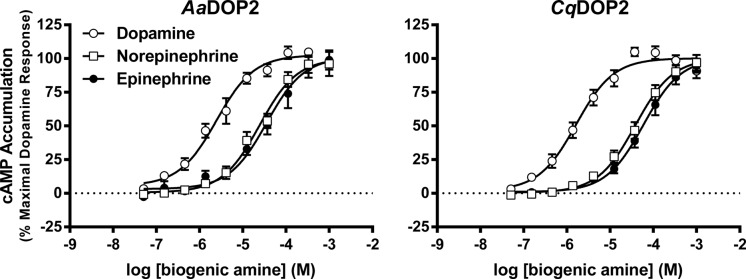
Pharmacological characterization of AaDOP2 and CqDOP2 stably expressed in HEK293 cells.Normalized cAMP response (mean ± SEM) seen as a function of concentration of dopamine, norepinephrine, and epinephrine for each receptor. The graphs are based on the compiled data (n ≥ 8 independent experiments, conducted in duplicate) and normalized using GraphPad Prism software to the maximal dopamine response for each experiment.